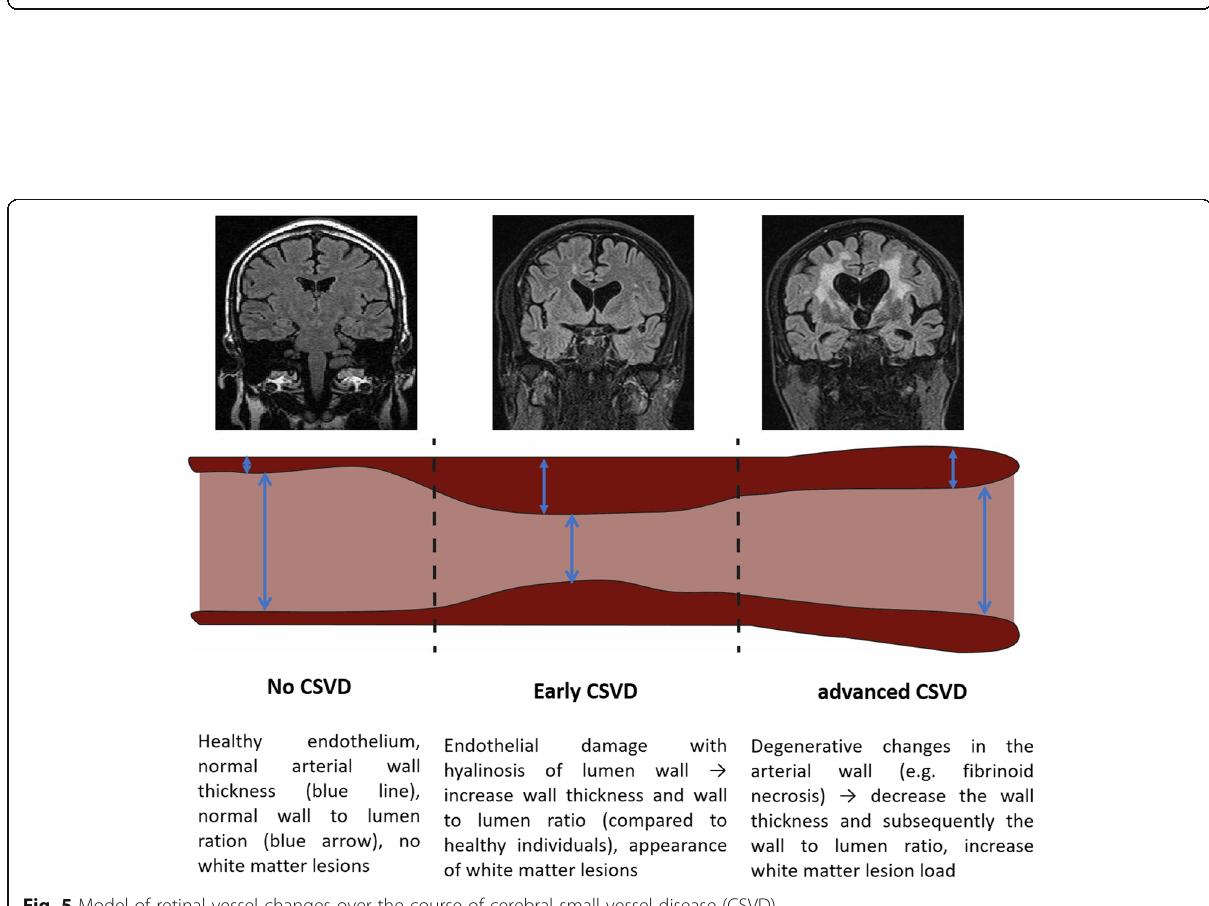
Fig. 5 Model of retinal vessel changes over the course of cerebral small vessel disease